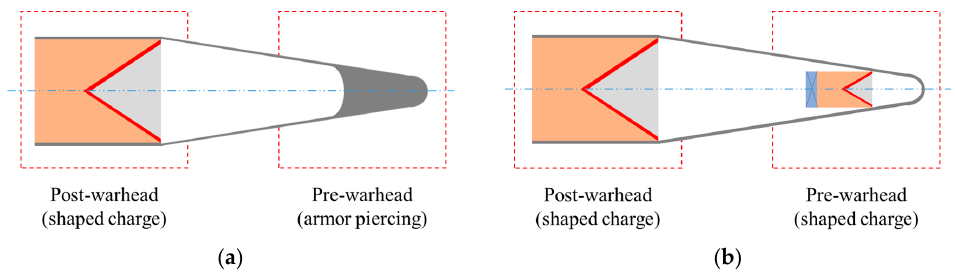
Figure 1. ( a ) Schematic diagram of the a rmor piercing-shaped charge type tandem warhead; and ( b ) schematic diagram of the shaped charge-shaped charge type tandem